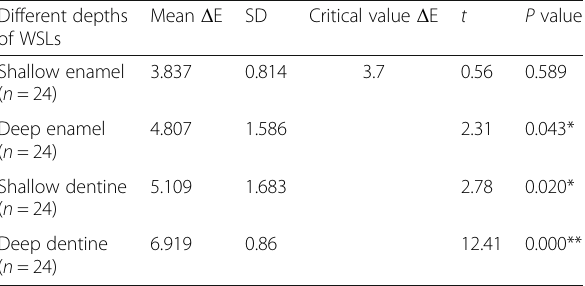
Table 1 Comparison of the mean Δ E after WSL formation (T1-T0) between each main group and the threshold of clinical detection Different depths of